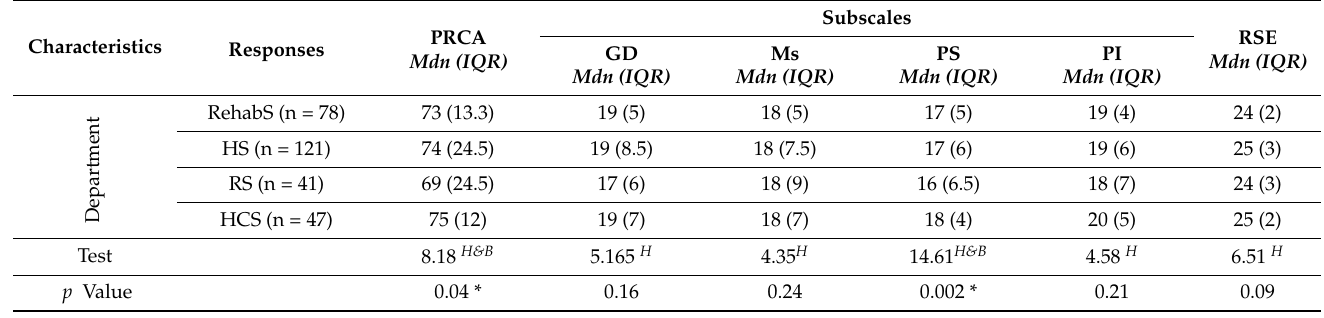
Table 4. Comparing PRCA and RSE in students from different departments (N =